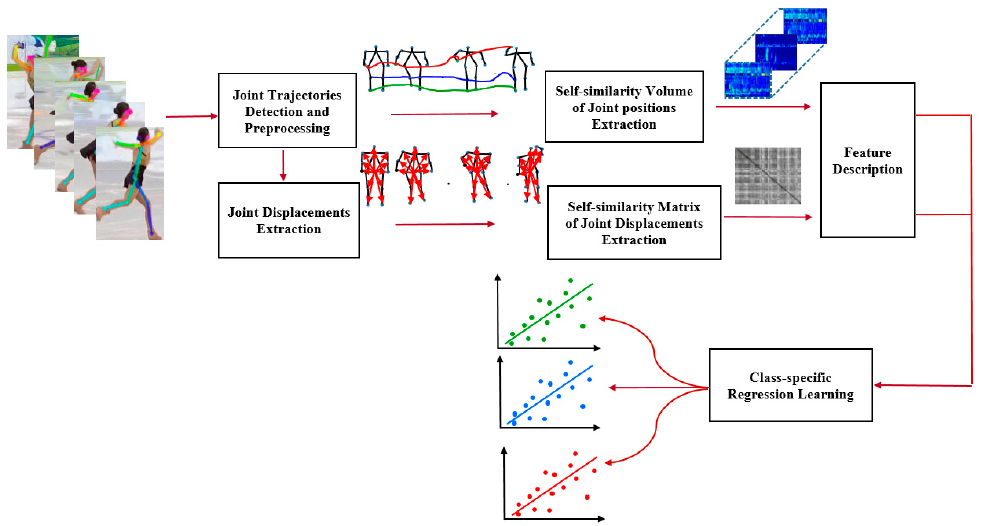
Figure 4. The training process of our quality assessment component. (The input of the action classification component was joint trajectories obtained by skeleton detection from an RGB video. Joint trajectory detection and preprocessing: We performed noise filtering, normalization, and spatial alignment processes for detected joint trajectories to deal with failure or false detection, scale variation, and spatial transformation of human motion. Joint displacement extraction: As the middle of the left hip and right hip was selected as the central point, the displacement of each joint relative to the central point was computed to represent the layout relationship between human body parts. Self-similarity volume of joint position extraction: Temporal self-similarity matrix of each joint trajectory was computed to capture view invariant patterns of intra-joint dynamic changes. Self- similarity matrix of joint displacement extraction: Temporal self-similarity matrix of all joint displacements was computed to capture view invariant patterns of inter-joint dynamic changes.